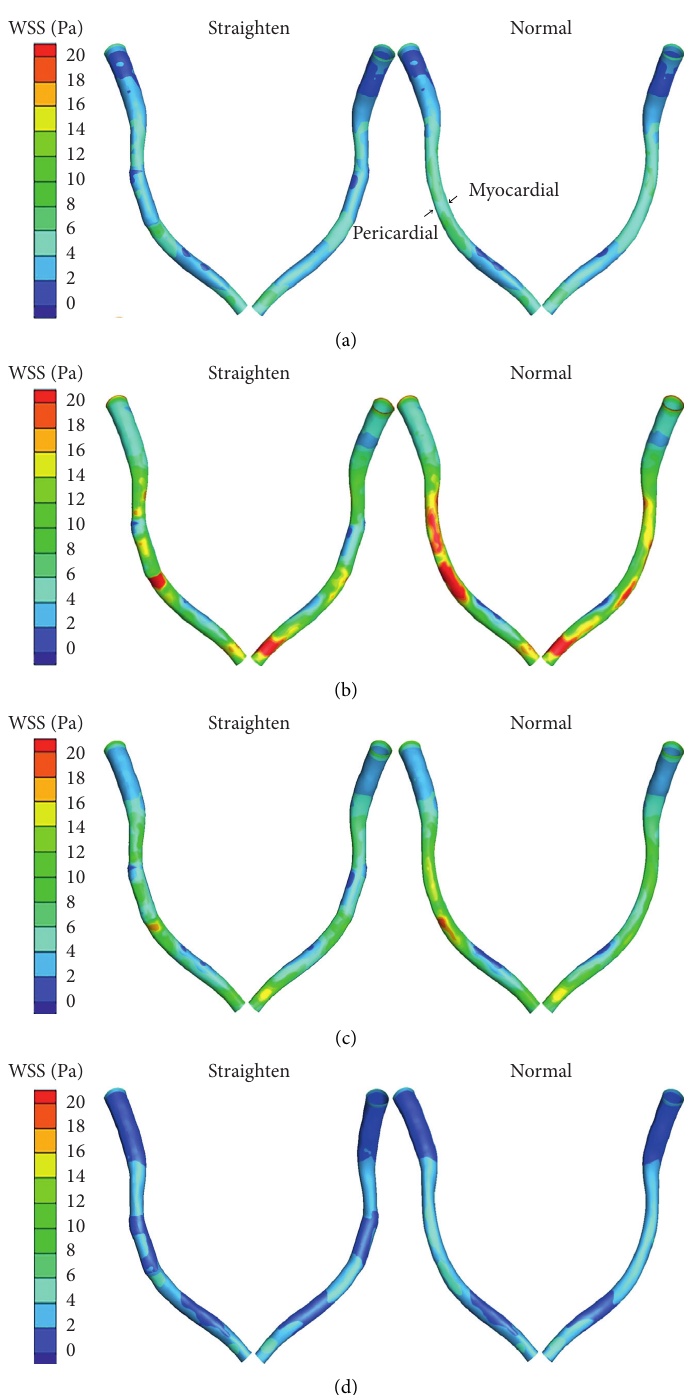
Figure 6: Counters of WSS at four typical points: (a) t